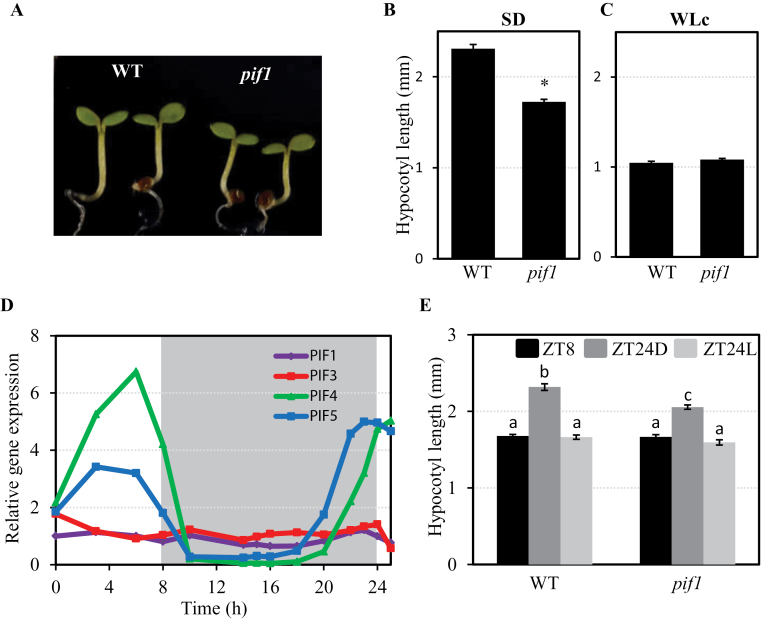
PIF1 promotes growth under SD conditions. (A) Visual phenotype of 3-day-old SD-grown WT and pif1 seedlings. (B) Hypocotyl length in 3-day-old SD-grown WT and pif1 seedlings. The asterisk indicates statistically significant differences (P-value <0.05). (C) Hypocotyl length in 3-day-old WT and pif1 seedlings grown under continuous WL (WLc). (D) Expression of PIF1, PIF3, PIF4, and PIF5 was analysed by quantitative RT–PCR. Values were normalized to PP2A, and expression levels relative to PIF1 at 0h are shown. Data represent the mean of technical replicates. (E) Hypocotyl length of 2-day-old SD-grown WT and pif1 grown as detailed in Fig. 1A. Data represent the mean and SE of at least 20 seedlings. Different letters denote significant differences among means (P < 0.05).